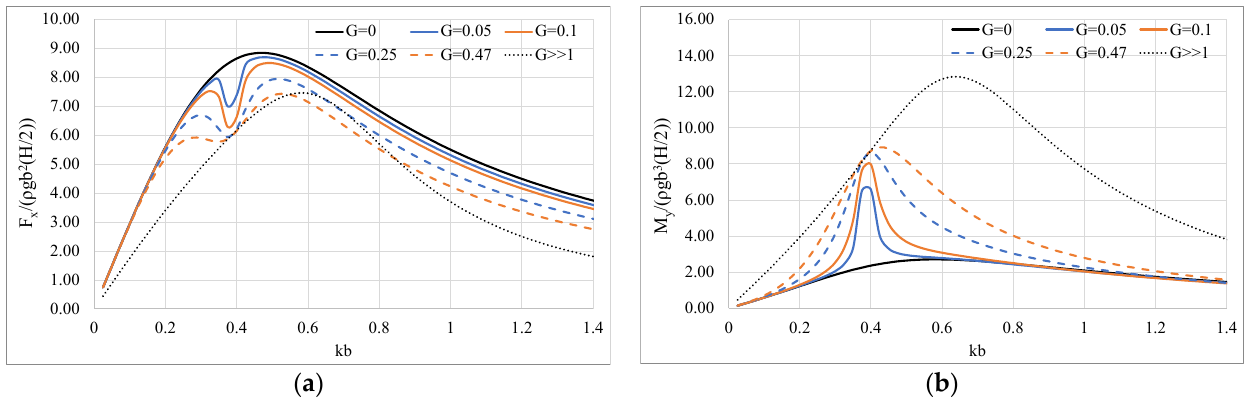
Figure 11. Effect of the porous coefficient 𝐺 on the horizontal exciting wave loads and overturning moments on a floating porous compound cylindrical body: ( a ) horizontal exciting forces; ( b ) overturning moments.